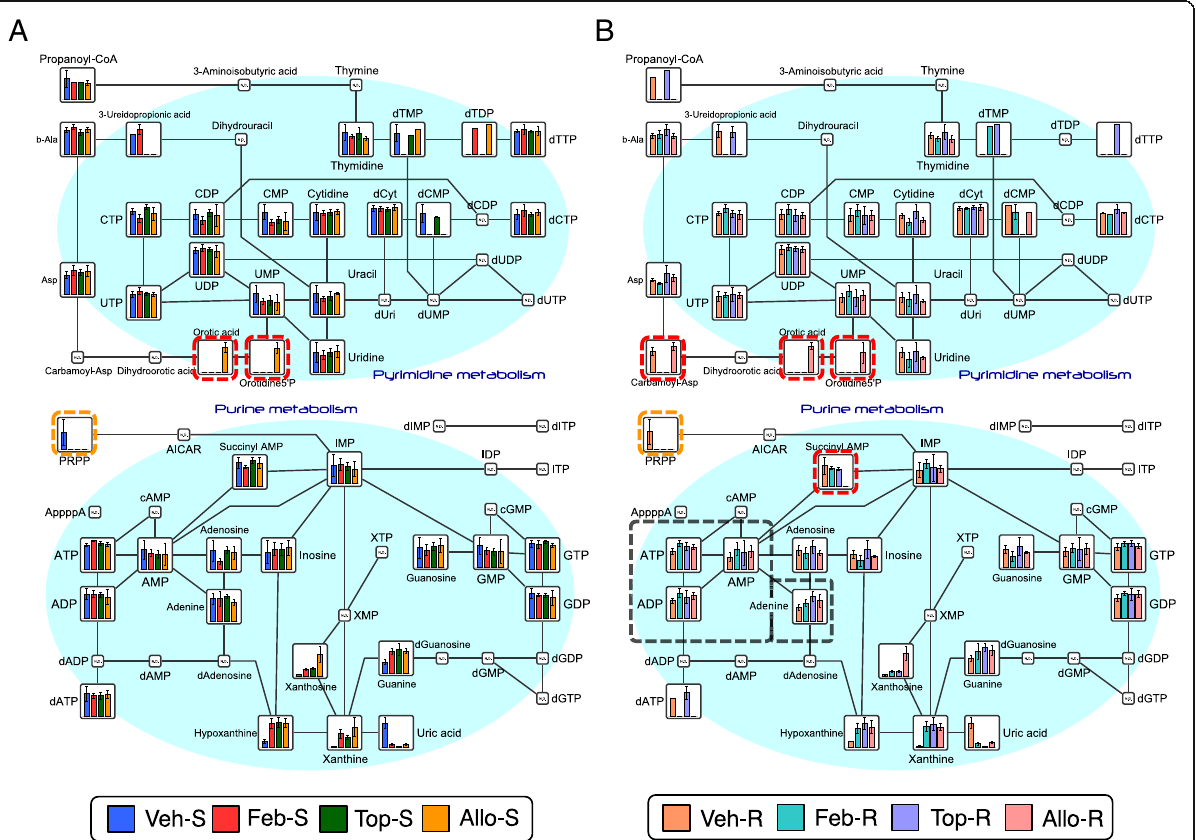
Fig. 3 Purine/pyrimidine metabolism pathway map in stationary and reperfused states. Pathway maps of purine/pyrimidine metabolism in both stationary ( a ) and reperfused ( b ) states show alterations in the concentrations of several metabolites. Uric acid in XOR inhibitor-treated groups was maintained at very low concentrations, whereas hypoxanthine and xanthine accumulated in XOR-R groups. PRPP was not detectable in inhibitor-treated groups ( a , b ; circled with an orange dashed line). ATP, ADP, AMP, IMP, and adenine levels were approximately 20 – 40% higher in XOR-R than in vehicle-treated rats in the reperfused state (B; circled with a black dashed line). Allopurinol treatment decreased succinyl AMP levels, whereas it increased orotic acid, orotidine 5 ′ -P, and carbamoyl-Asp levels ( a , b ; circled with a red dashed line). PRPP, phosphoribosyl diphosphate; ATP, adenosine triphosphate; ADP, adenosine diphosphate; AMP, adenosine 5 ′ -monophosphate; IMP, inosinic acid; GTP, guanosine triphosphate; GDP, guanosine 5 ′ -diphosphate; GMP, guanosine 5 ′ -monophosphate; CTP, cytidine triphosphate; CDP, cytidine 5 ′ -diphosphate; CMP, cytidine 5 ′ -monophosphate; UDP, uridine diphosphate; UMP, uridine 5 ′ -monophosphate; succinyl AMP, adenylosuccinic acid; orotidine 5 ′ -P, orotidine 5 ′ -monophosphate; carbamoyl-Asp, N-carbamoylasparatic